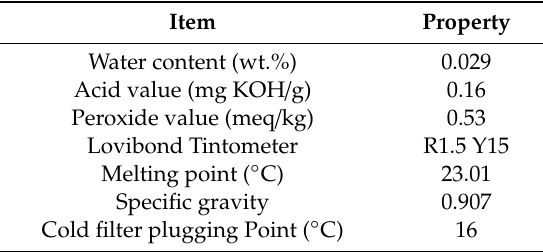
Table 1. Properties of palm oil